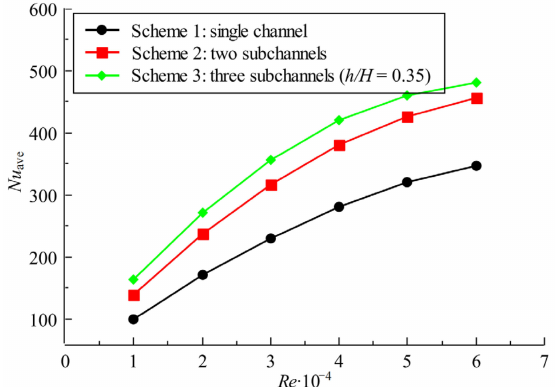
Figure 9. Comparison of the heat transfer performance of X-shaped truss array channels for different layout